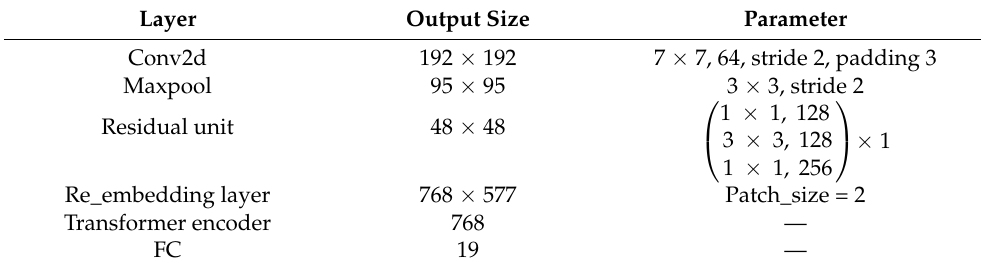
Table 1. ReVI main network layers and